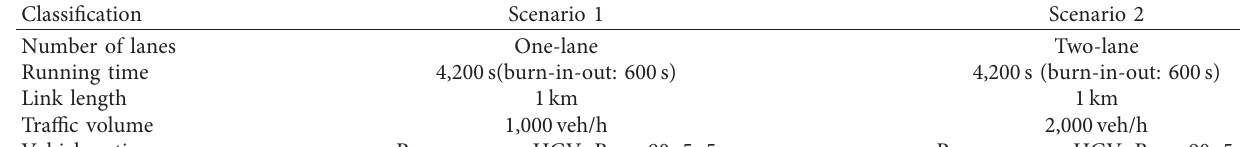
Table 1: Scenario descriptions of numerical evaluation.